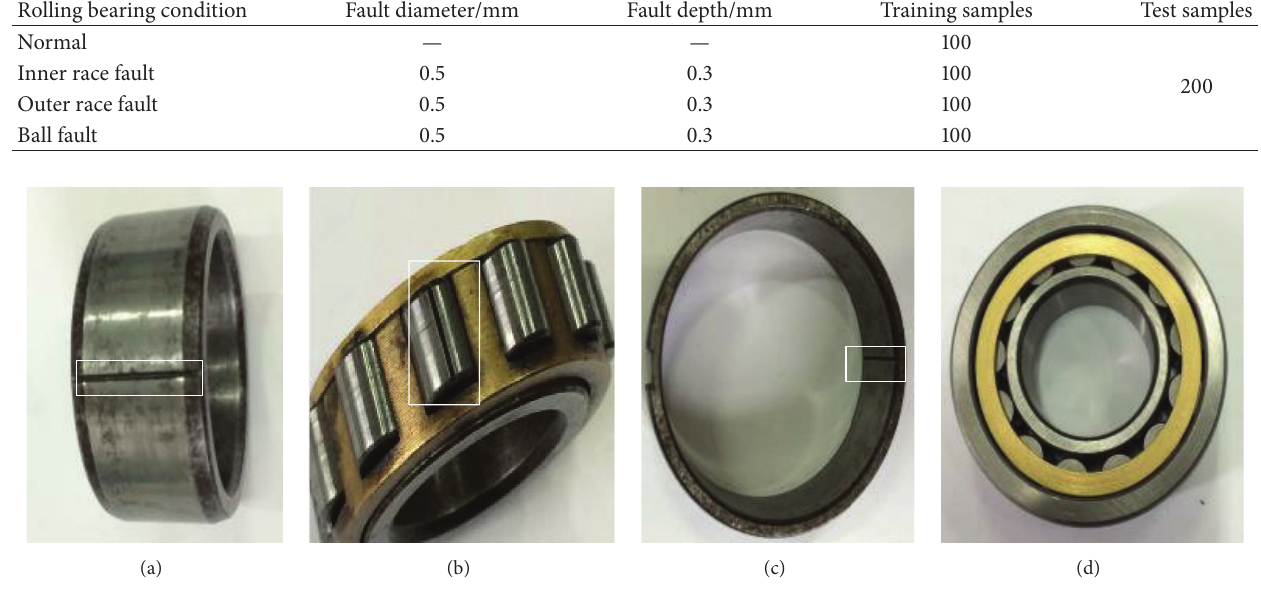
Figure 5: Pictures of the testing bearings: (a) inner race fault; (b) ball fault; (c) outer race fault; (d) normal.